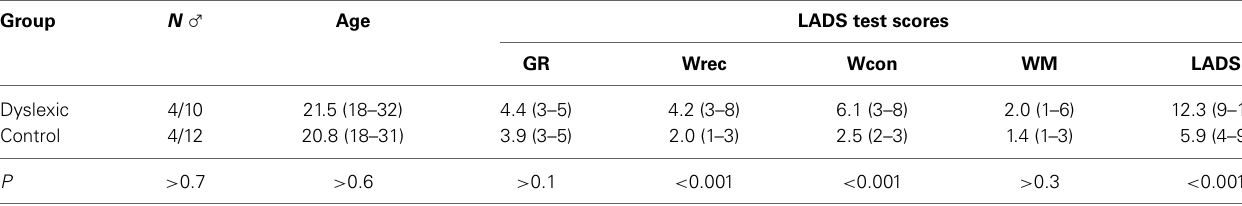
Table 1 | Participant details shown as means (ranges in brackets) per